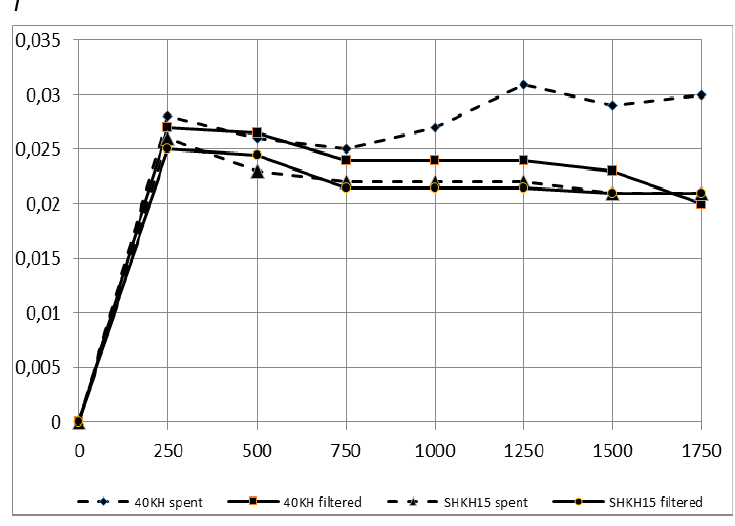
Fig. 5. Change of friction coefficient ( f ) with operating time depending on used steel grades and type of